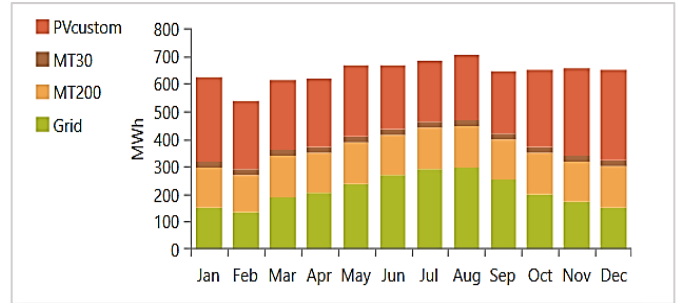
Figure 11. Monthly electrical production of the designed system components.